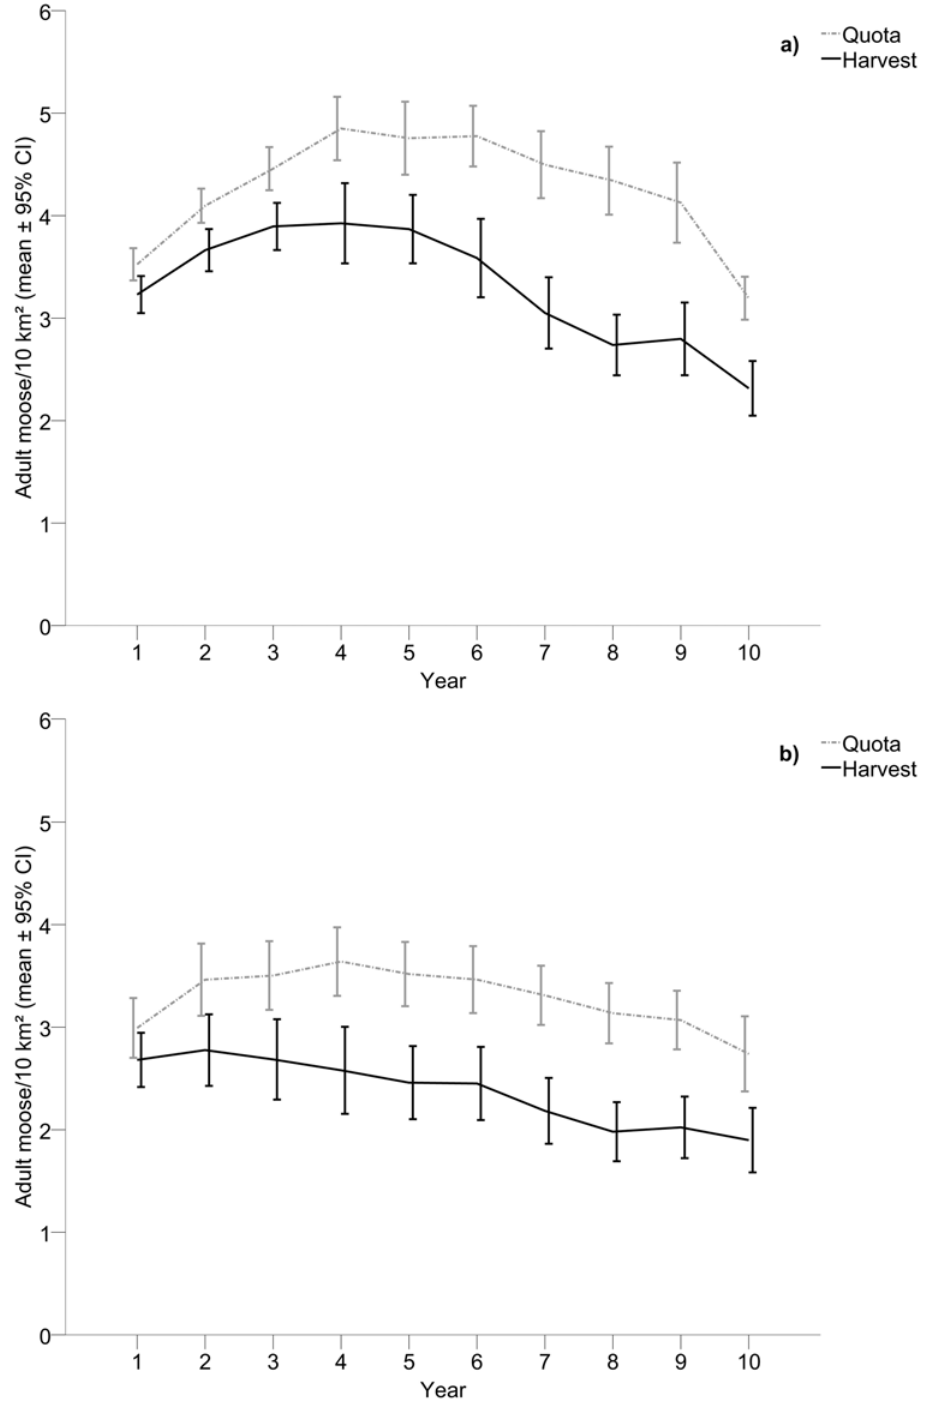
Fig 4. Quota and harvest of adult moose within wolf territories compared to control areas. Quota and hunter harvest of adult moose (males and females pooled) within a) wolf territories with at least ten years of presence of wolves (n = 38) and b) adjacent control